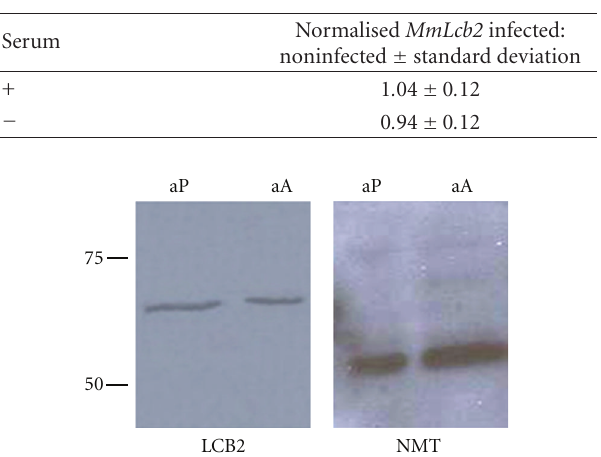
Table 1: Expression of MmLcb2 in infected and noninfected macro- phages.